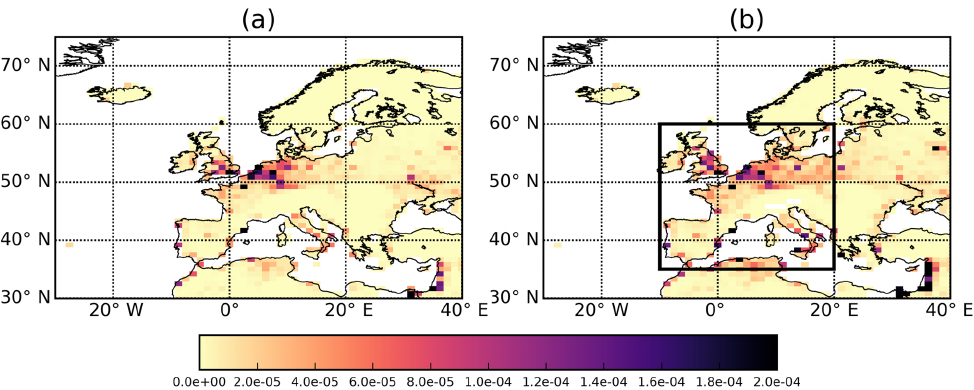
Figure 4. DJF average of 6-hourly SSI for ERA-Interim (a) and HiGEM (b) . The black box region in (b) is our SSI calculation region.